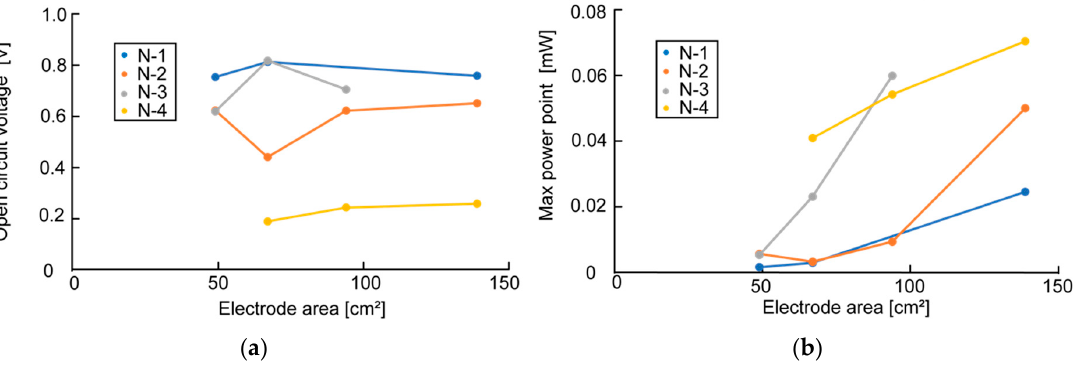
Figure 6. Measurement results of OCV and MPP in the experiment of changing the electrode area: ( a ) measurement result of OCV; ( b ) measurement result of MPP.